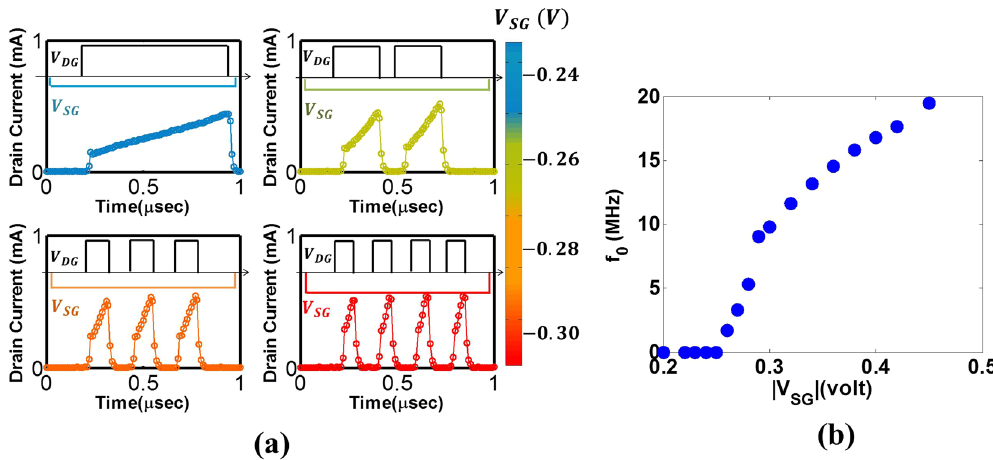
Figure 5. ( a ) The LIF function for different input (V SG ) is shown with a V DG based reset. At threshold (I D ≥ I th = 500 μ A), V DG is grounded to reset the neuron for 100 ns, then set back to V DG = 2.8 V. The output current starts from the same initial point after each reset – essentially make each LIF cycle identical. As V SG